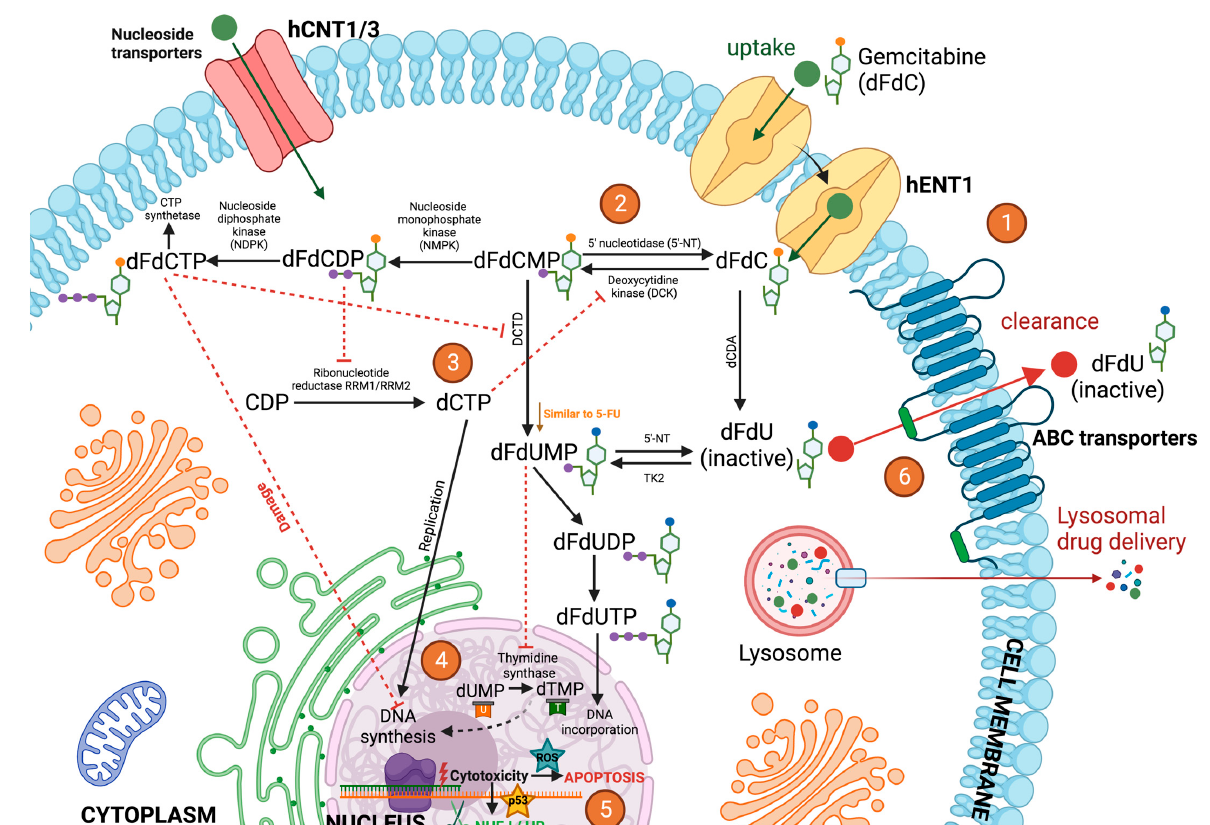
Figure 2. Mechanism of action of gemcitabine via cellular metabolism. (1) Once administered, gemcitabine (dFdC) is transported into cells by nucleoside transporters such as hENT1. (2) Gemcitabine is then phosphorylated into gemcitabine monophosphate (dFdCMP) by deoxycytidine kinase (DCK), and dFdCMP is subsequently phosphorylated to gemcitabine diphosphate (dFdCDP) and gemcitabine triphosphate (dFdCTP) by nucleoside monophosphate kinase (NMPK) and nucleoside diphosphate kinase (NDPK). (3) dFdCDP potently inhibits ribonucleotide reductase (RR) RRM1/RRM2, resulting in a decrease in the competing deoxyribonucleotide pools necessary for DNA synthesis. RR transforms cytidine diphosphate (CDP) into deoxycytidine diphosphate (dCDP), and its inhibitory effect leads to the decreased concentration of competitive deoxycytidine triphosphate (dCTP) pool cells required for DNA synthesis, thus promoting the binding of dFdCTP to DNA. Gemcitabine exerts its cytotoxic effect mainly through the inhibition of DNA synthesis by being incorporated into the DNA strand as the active dFdCTP. dFdCTP suppresses activation of dFdCMP by inhibiting deoxycytidine monophosphate deaminase (DCTD). (4) dFdCTP in the nuclei inhibits Deoxyribonucleic Acid (DNA) and Ribonucleic Acid (RNA) synthesis. 2 ′ ,2 ′ -difluorodeoxyuridine monophosphate (dFdUMP) inhibits thymidine synthase (TS), resulting in the depletion of the deoxythymidine monophosphate (dTMP) pool, but it can also be phosphorylated to 2 ′ ,2 ′ -difluorodeoxyuridine triphosphate (dFdUTP) for its DNA incorporation or dephosphorylated to 2 ′ ,2 ′ -difluorodeoxyuridine (dFdU) and then trans- ported out of the cells. (5) Gemcitabine cytotoxicity activates DNA damage responses such as NHEJ, HR, and p53 . Gemcitabine can also induce DNA damage by further promoting the accumulation of ROS, thereby enhancing apoptosis. On the other hand, p53 mutations can contribute to intracellular ROS accumulation and thus to genomic instability, which is characteristic of malignant cells. (6) The majority of dFdC is inactivated mainly by the deoxycytidine deaminase (dCDA)-mediated conversion to dFdU and then excreted through the ABC transporters. Deamination of dFdCMP to dFdUMP by DCTD and its subsequent dephosphorylation form, dFdU, is another inactivation pathway of